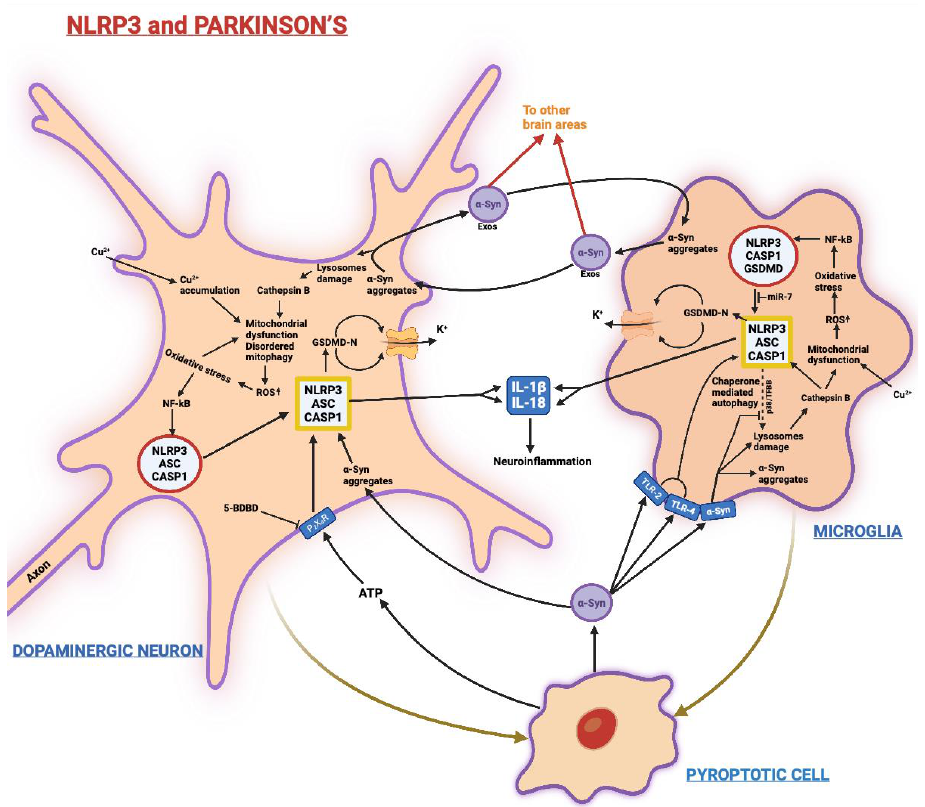
Figure 3 sums up the main signaling pathways involving NLRP3 in PD.